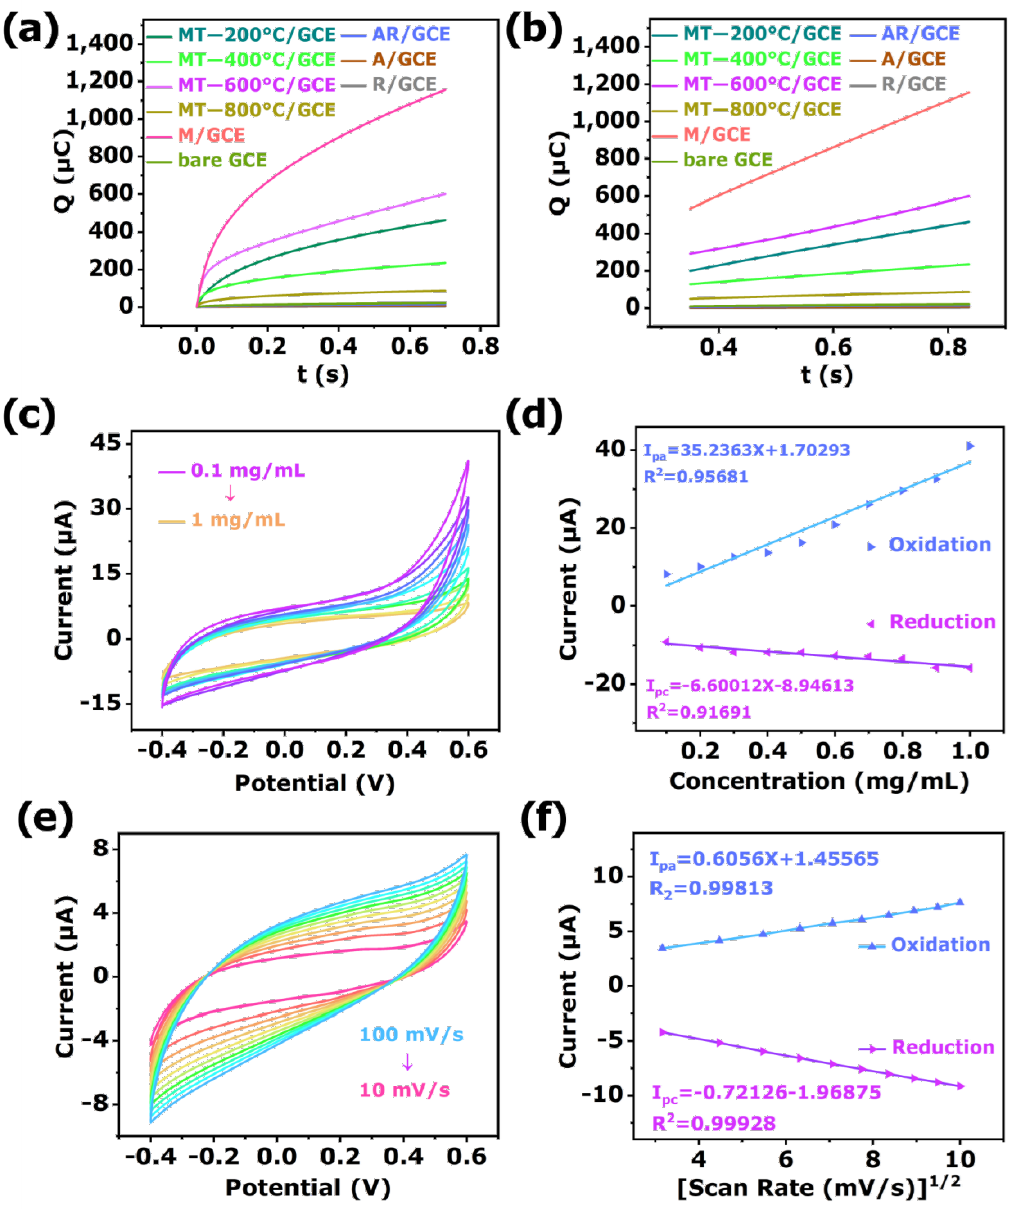
Figure 6. Plot of ( a ) Q-t and ( b ) Q-t 1/2 curves of the bare GCE, A/GCE, R/GCE, AR/GCE, M/GCE, and MT-600 ℃ /GCE in 0.1 mM K 3 [Fe(CN) 6 ] solution containing 1 M KCl. ( c ) CV of different concentrations (from 0.1 to 1 mg/mL) of β -Casein on MT-600 ℃ /GCE in artificial sweat (pH = 7.0) and ( d ) linear relationship between the redox peak currents and the concentration of β -Casein. ( e ) CV of MT-600 ℃ /GCE in artificial sweat (pH = 7.0) containing 1 mg/mL β -Casein with different scan rates (from 10 to 100 mV/s) and ( f ) linear relationship between the redox peaks currents and scan rate square root.